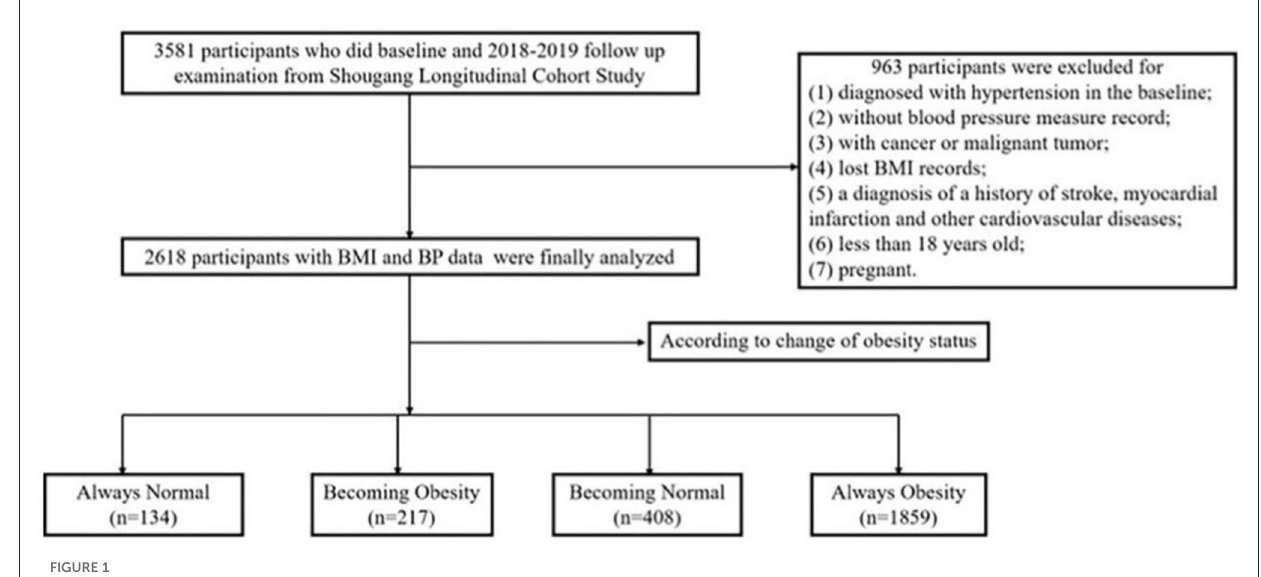
FIGURE1 Flow chart of this cohort study.